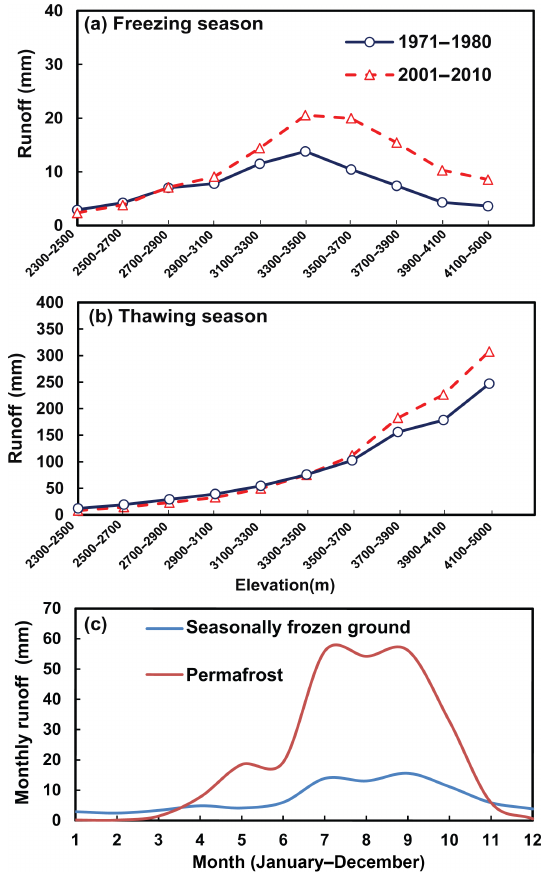
Figure 13. Model-simulated runoff showing changes from the 1971–1980 period to the 2001–2010 period with elevation for (a) the freezing season and (b) the thawing season, and (c) monthly averaged seasonal runoff in permafrost and seasonally frozen ground for the period of